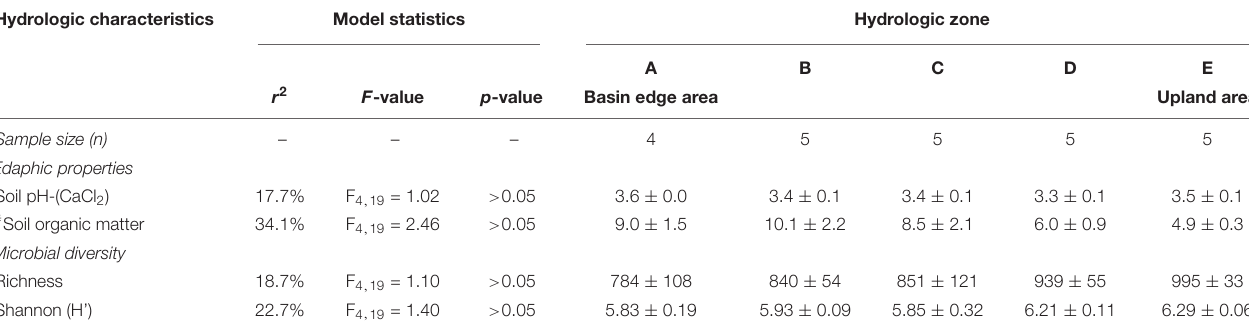
FIGURE 2 | (A) Wetland hydrograph showing the mean and standard error of the mean (SEM) of wetland water level experienced across the 2018 water year. (B) Mean water level, (C) inundation duration, and (D) saturation frequency experienced at each transect point across the study wetlands. Here, water level is relative to the ground surface, where positive values indicate surface inundation and negative values indicate water level is below ground surface. TABLE 2 | Edaphic and microbial community diversity properties for each hydrologic zone (A–E) established along the topographic